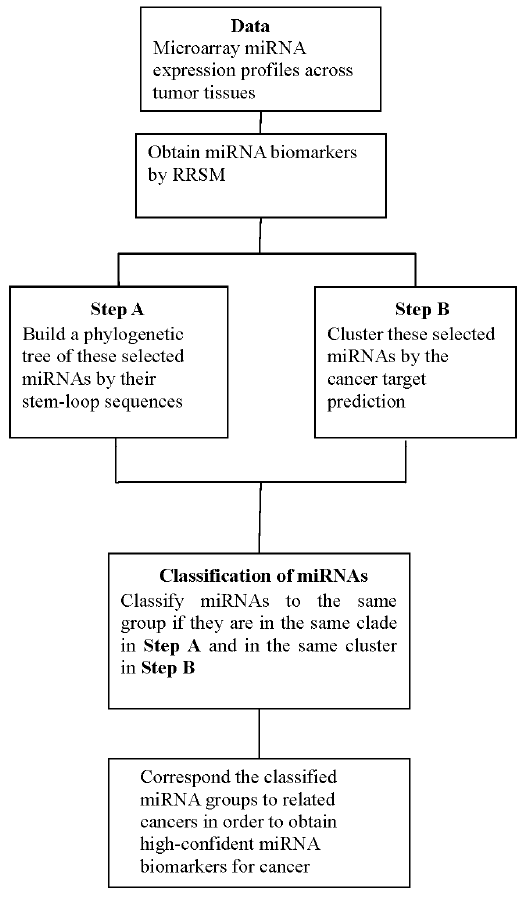
Figure 4. The flowchart of the method.